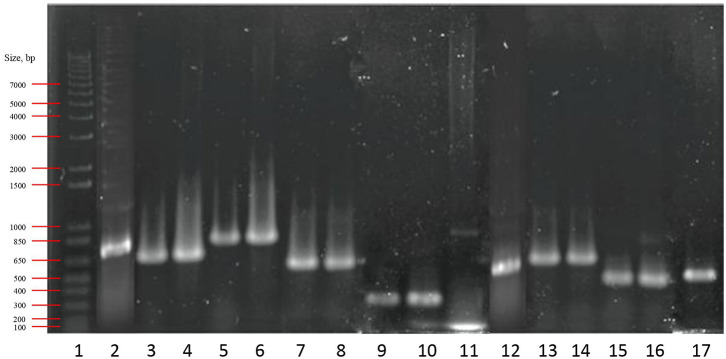
PCR products of the glutathione reductase and selenocysteine lyase genes. Lanes: 1, molecular weight marker (1 Kb Plus DNA Ladder; InvitrogenTM, CA, USA); 2, 3, 4, 5, 6, 7, 8, 9, 10, and 11, glutathione reductase; 12, 13, 14, 15, 16, and 17, selenocysteine lyase. Lanes 2 and 12 correspond to Lc lactis CRL 2011; 3, 5, and 15, W. cibaria 10; 4, 6, and 16 W. cibaria 25; 7 and 13, Ec. casseliflavus 47; 8 and 14, Ec. casseliflavus 82; 9, Lb. brevis CRL 2051; 10, Lb. plantarum CRL 2030; while lanes 11 and 17 correspond to F. tropaeoli CRL 2034.